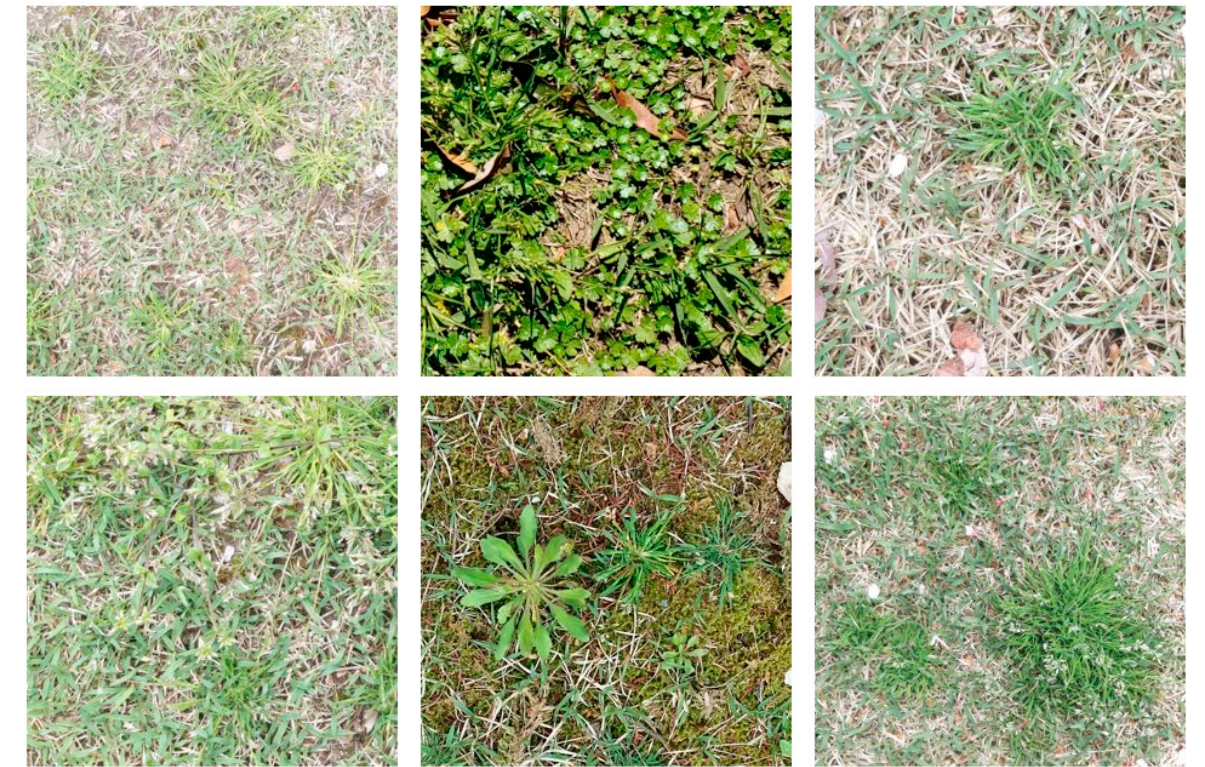
Figure 5. Examples of original images in the weed dataset. From left to right: The first row contains clover, common ragweed, crabgrass, dandelion and ground ivy; the second row contains lambsquarter, pigweed, plantain, tall fescue and unknown weed. (In the sample shown in this fig- ure, each picture has only one category of weed, but each picture in the actual collected dataset may have the appearance of multiple types of weeds).